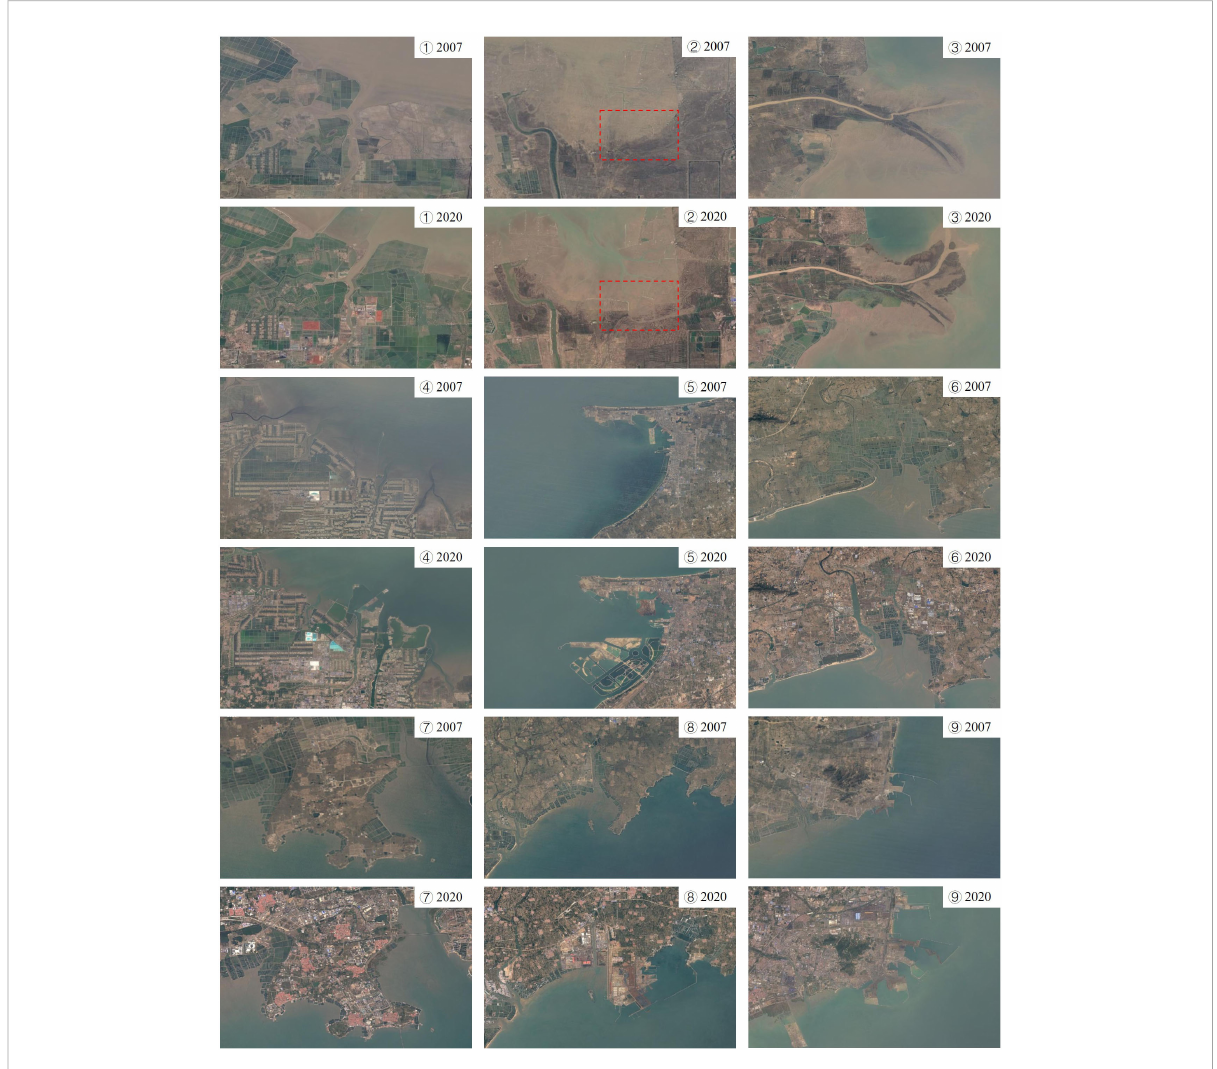
FIGURE 5 Remote sensing images showing typical examples of shoreline change for the period of 2007 –